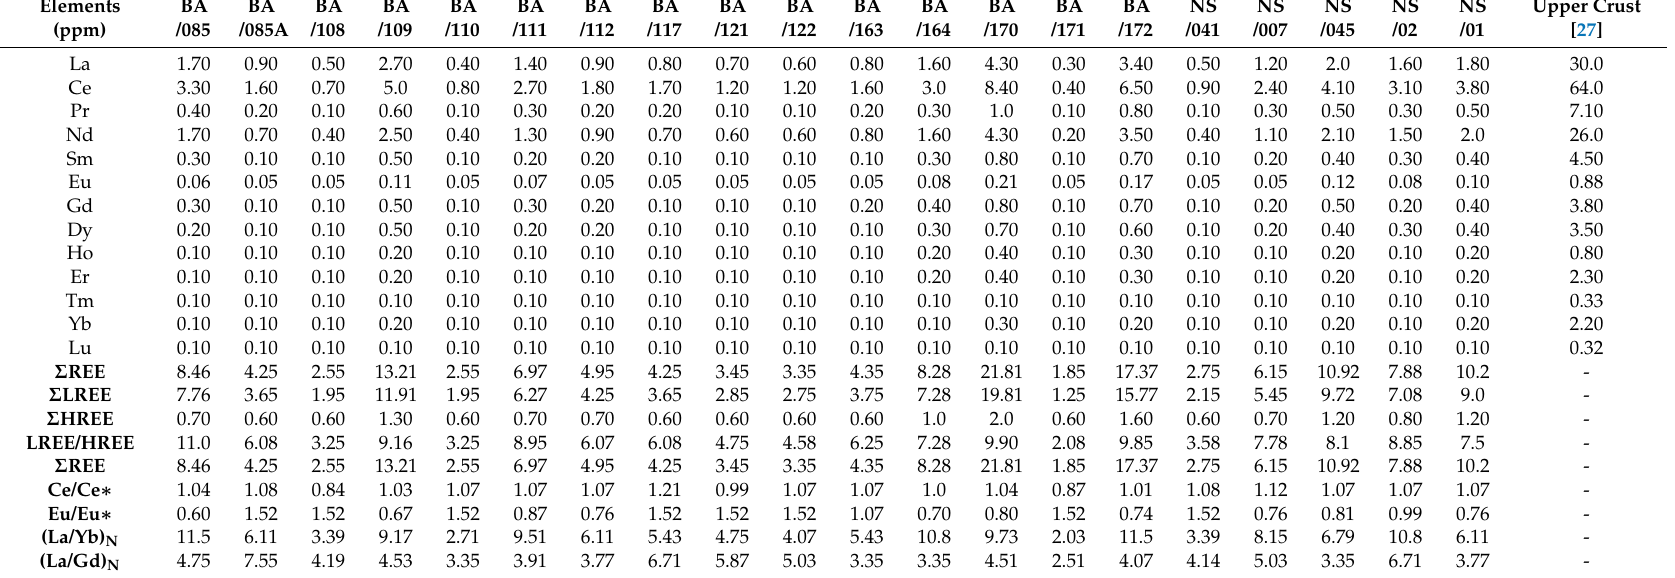
Table 3. Concentration of rare earth elements